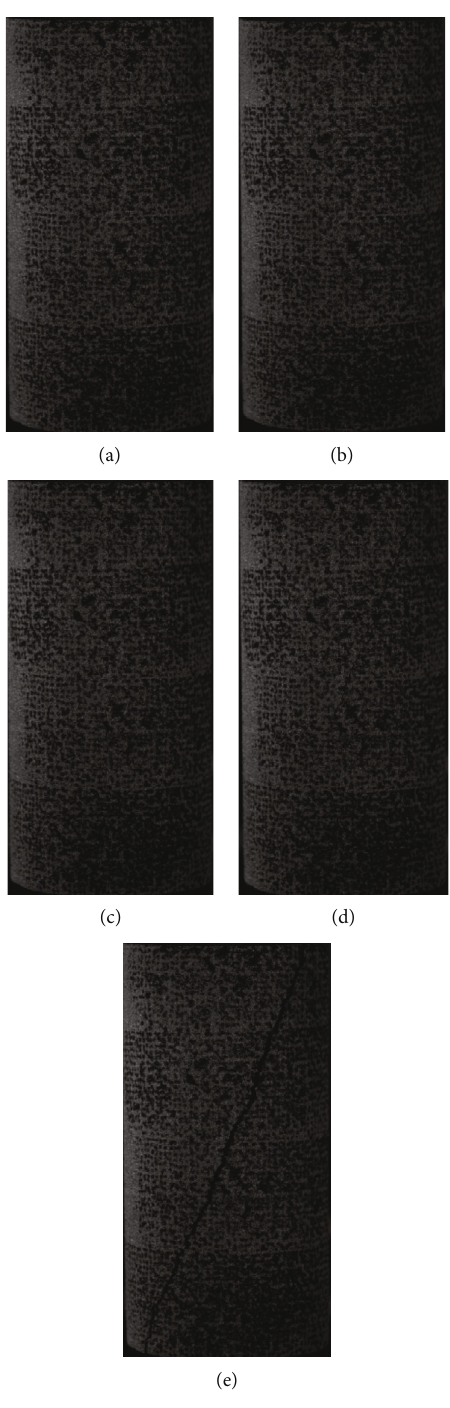
Figure 9: Digital images under (a) initial stage, (b) torsion application stage, (c) peak torsion stage, (d) 22.5s after peak torque stage, and (e) 39s after peak torque